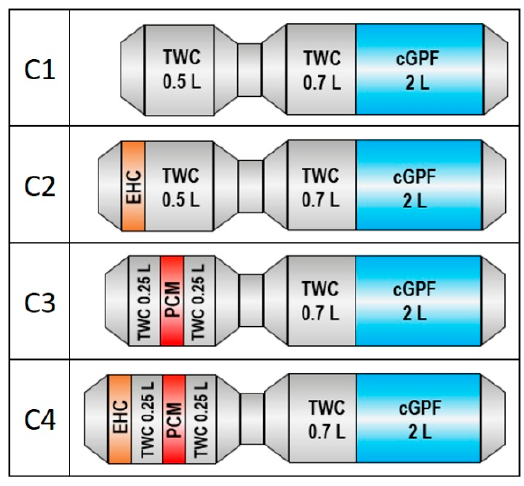
Figure 19. The evaluated EAT configurations.